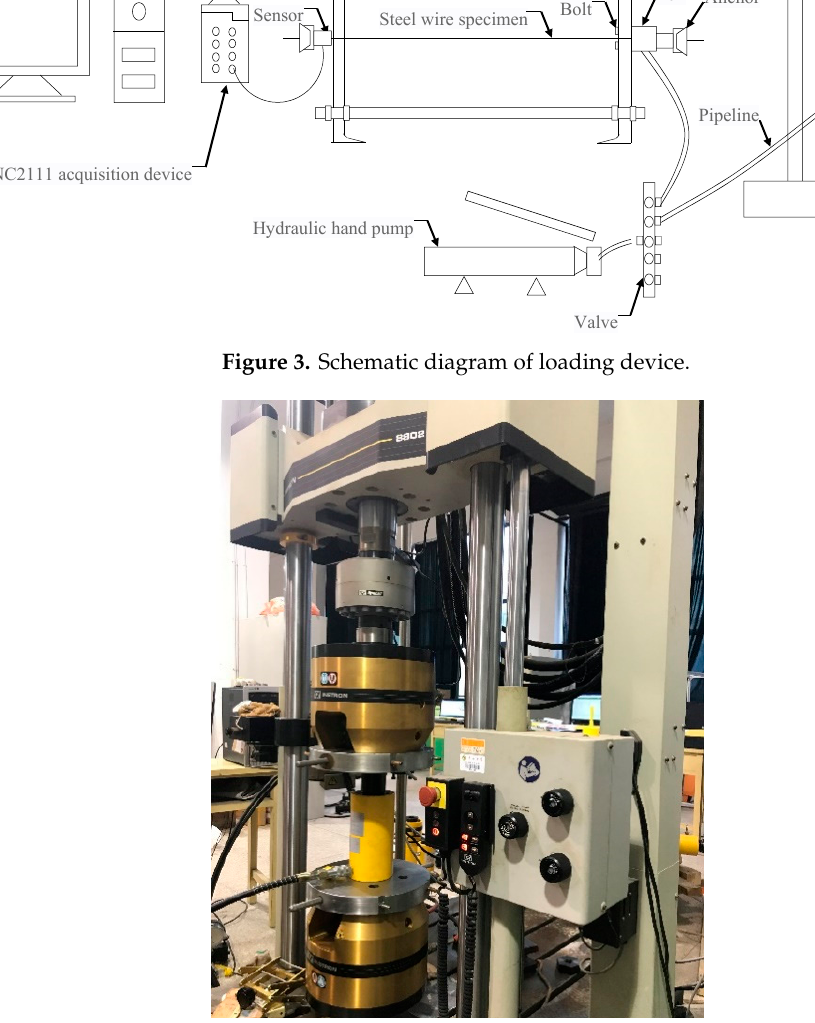
Figure 4. Fatigue testing machine—INSTRON 8802.